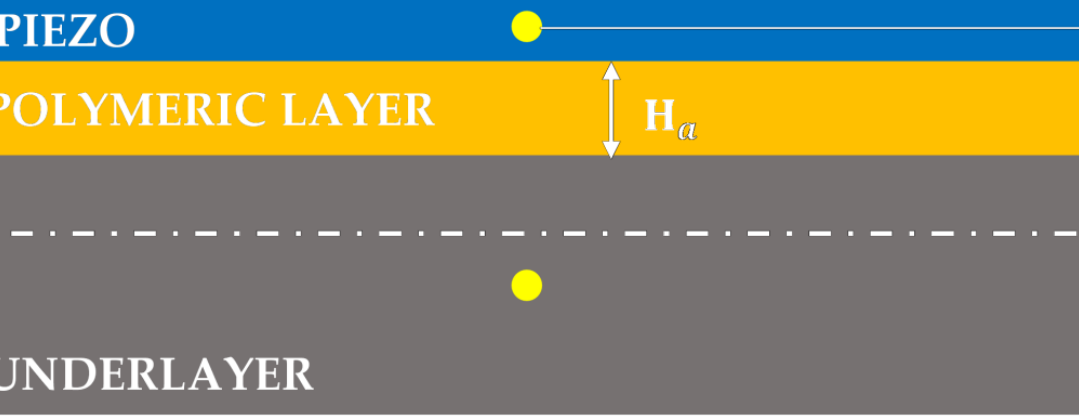
Figure 16. Cross-section of the model with the interposed layer.